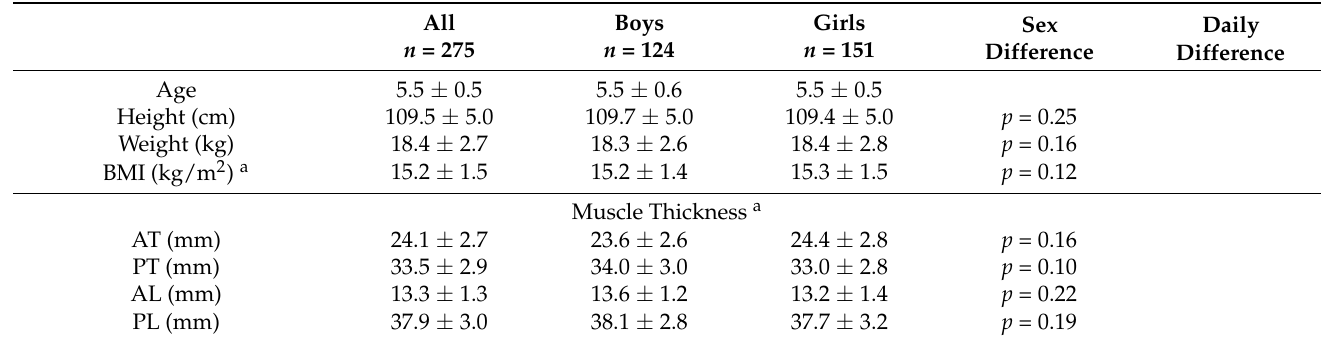
Table 1. Descriptive statistics for characteristics, muscle thickness, and physical activity in both boys and